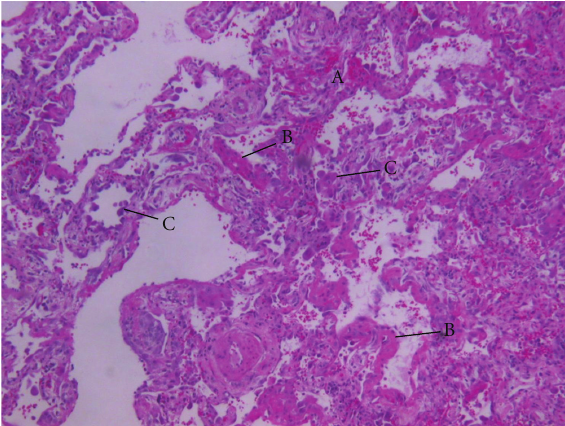
Figure 3: Histopathology showed di ff use alveolar damage pattern- mixed exudative and organizing phase, as demonstrated by video- assisted thoracostomy lung biopsy: showing interstitial edema and hemorrhage (A), di ff use alveolar wall thickening by proliferating connective tissue, formation of hyaline membranes, (B) and type II pneumocyte hyperplasia (C), (hematoxylin- eosin stain) (original ×